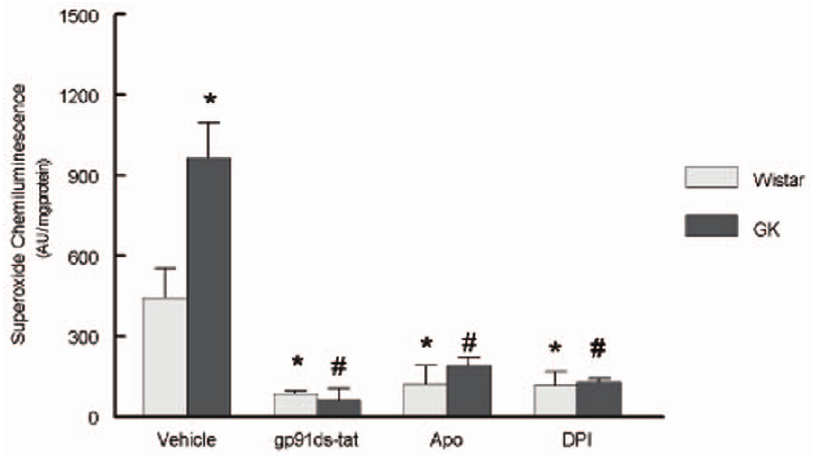
Figure 4. Diabetes significantly increased superoxide production in aortic tissue. A small portion of the abdominal aorta was resected from nine month old GK and Wistar rats. Superoxide was determined by lucigenin chemiluminescence, using 5 6 10 2 6 mol/L lucigenin and 2 6 10 2 4 mol/L NADPH. To determine if superoxide generation was derived specifically from NADPH tissue samples were incubated with three different inhibitors of NADPH; apocynin (APO), diphenyleneiodoium (DPI), and gp91ds-tat. Values are mean 6 SEM of 5 animals. * p , .05 compared to Wistar control, # p , .05 compared to GK control.